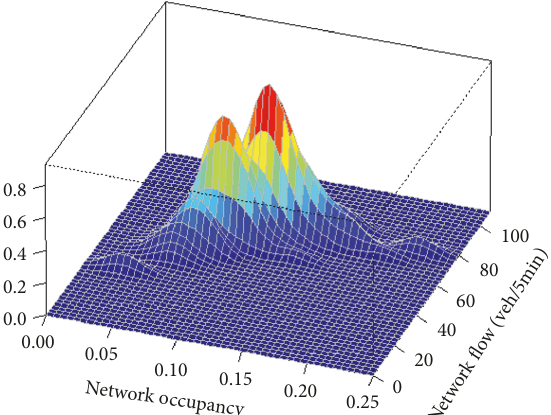
Figure 7: Visualization of the distribution of the CTS points.